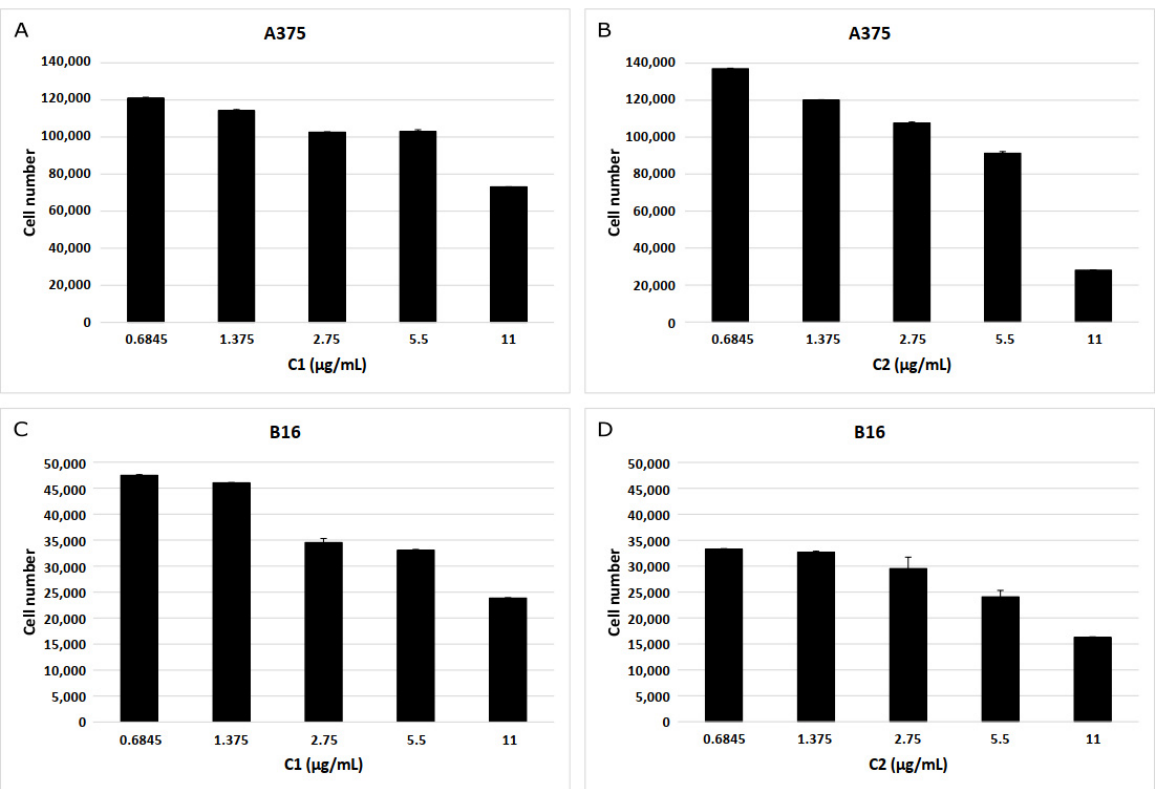
Figure 5. MTT reductase activity of human and mouse melanoma cells after exposure to C1 and C2. Both human (A375, upper panels) and mouse (B16, lower panels) melanoma cells were exposed to variable concentrations of hit compounds C1 ( A , B ) and C2 ( C , D ) for 48 h.